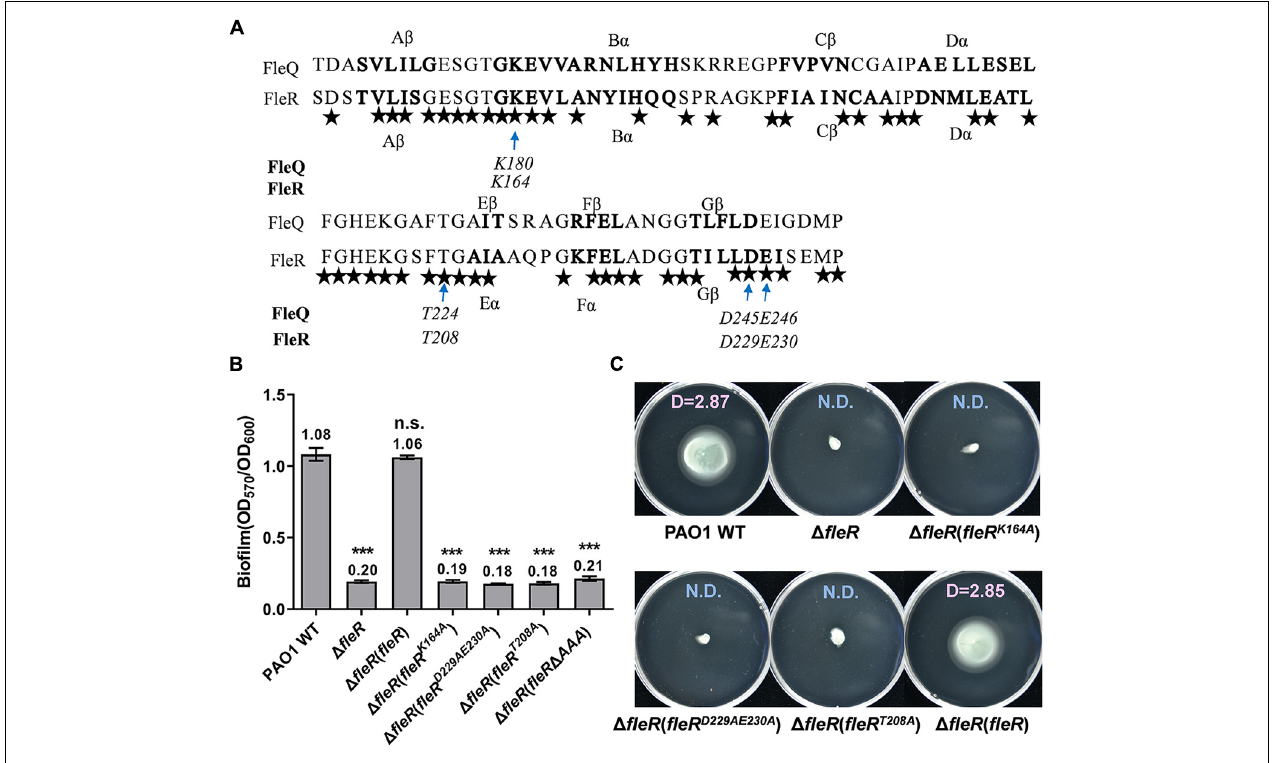
FIGURE 5 | Analysis of the conserved amino acids in the AAA domain of FleR. (A) . The AAA domain of FleR displays a similar structural fold and shares the conserved key residues with the AAA domain of FleQ (WP_003086448.1). The α helix and β sheet of FleR and FleQ shown in bold were predicted using PredictProtein (http://cubic.bioc.columbia.edu/). The arrows indicate the conserved amino acid residues which are the key residues in the Walker A, Walker B and σ 54 -binding motifs in FleQ. All the identical residues in FleR and FleQ are indicated by stars. (B,C) The role of K164, D229&E230, T208 in FleR-AAA in controlling biofilm formation (B) and swimming motility (C) was examined by ectopic expression of FleR containing K164A, D229A&E230A, T208A in the (cid:49) fleR strain, respectively. *** P < 0.001, n.s., no significance (Student’s t- test). Representative images and the average diameter (D) of the swimming migration zone of each strain are shown. N.D., not detected. Each experiment was performed in